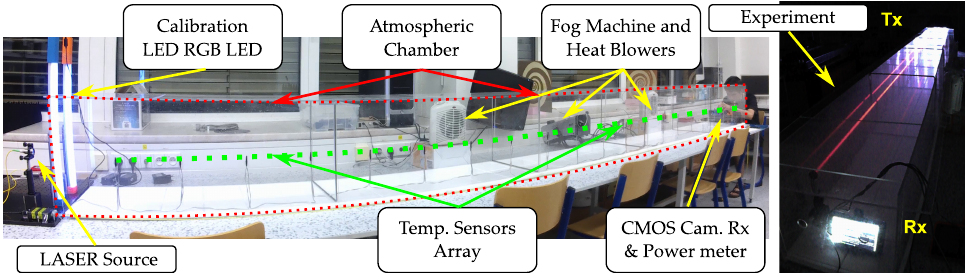
Figure 3. Photos of the laboratory setup utilized in the